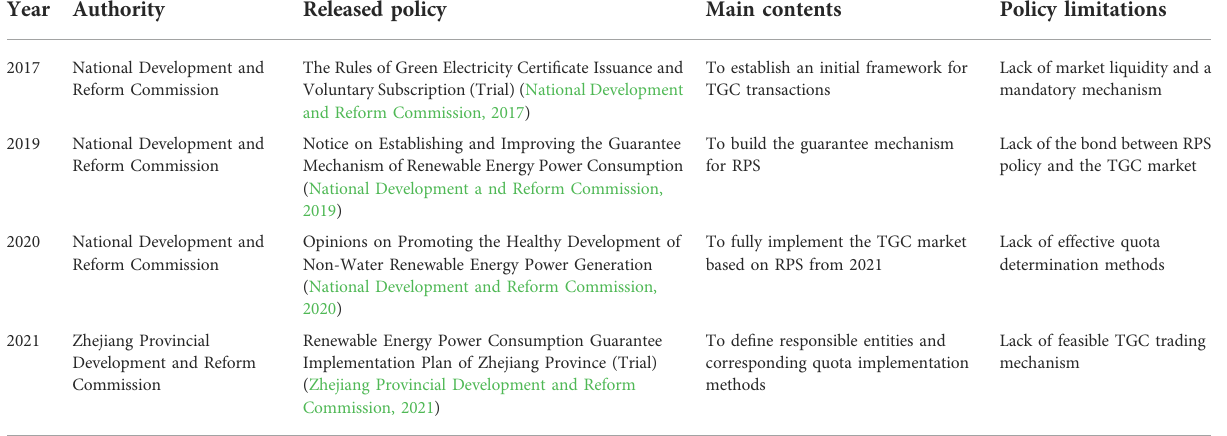
TABLE 1 Issued policies in renewable energy in